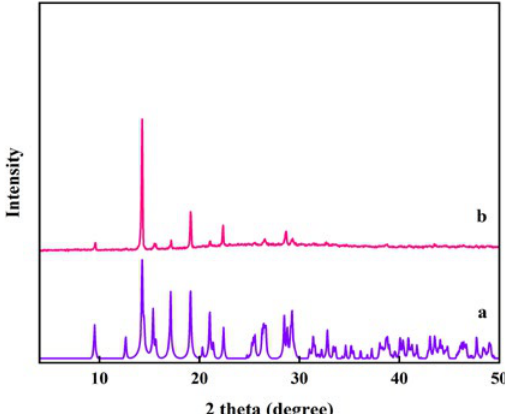
Fig. 1. X-ray powder pattern of [Cu (a) The simulated pattern of single crystal X-ray data and (b) experimental pattern of as-synthesized MOF.